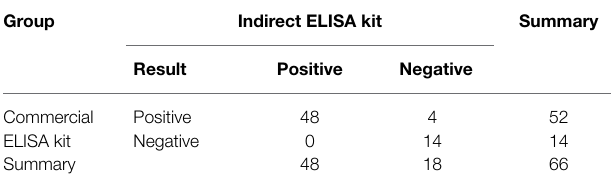
TABLE 1 | Detection of clinical serum